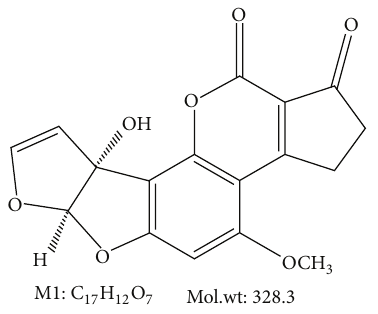
Figure 1: Structural formula for aflatoxin M1.